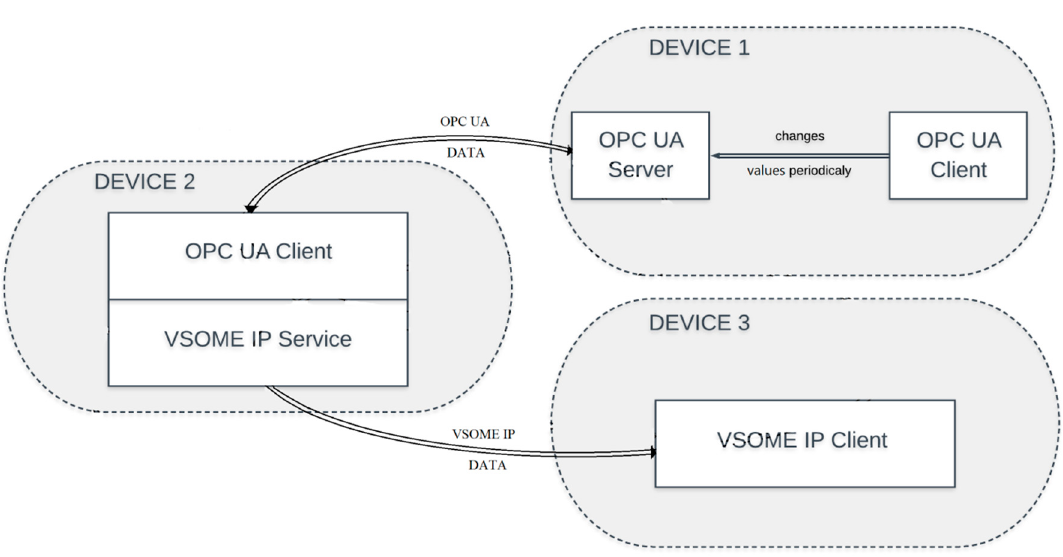
Figure 6. The three devices used in the case study architecture.